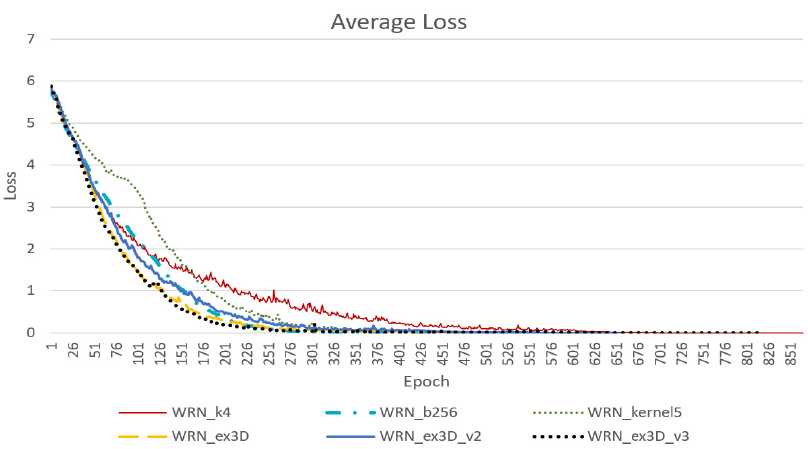
Figure 12. Convergence results of average loss under the condition where the samples were randomly distributed between training and testing sets at a 5:5 ratio.